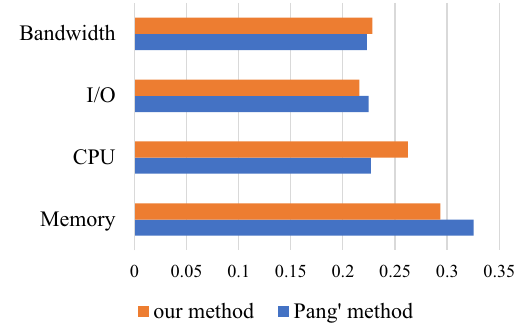
Fuzzy value value